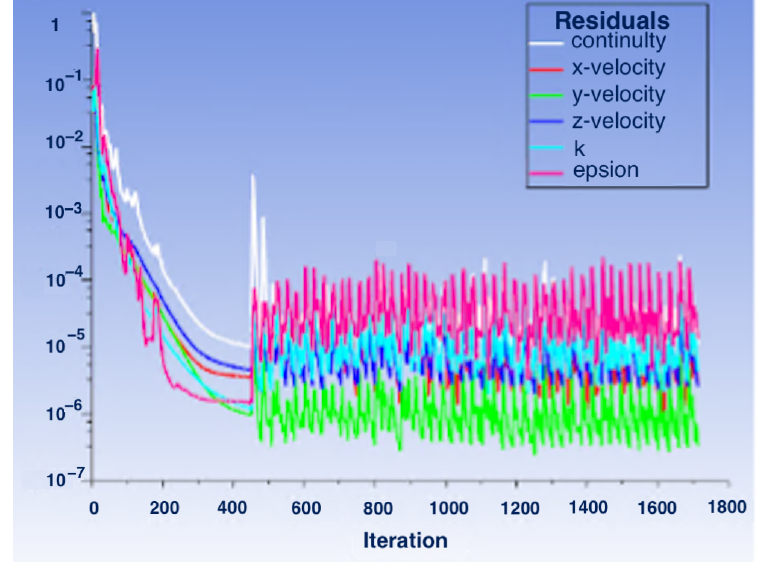
Figure 8. The simulation